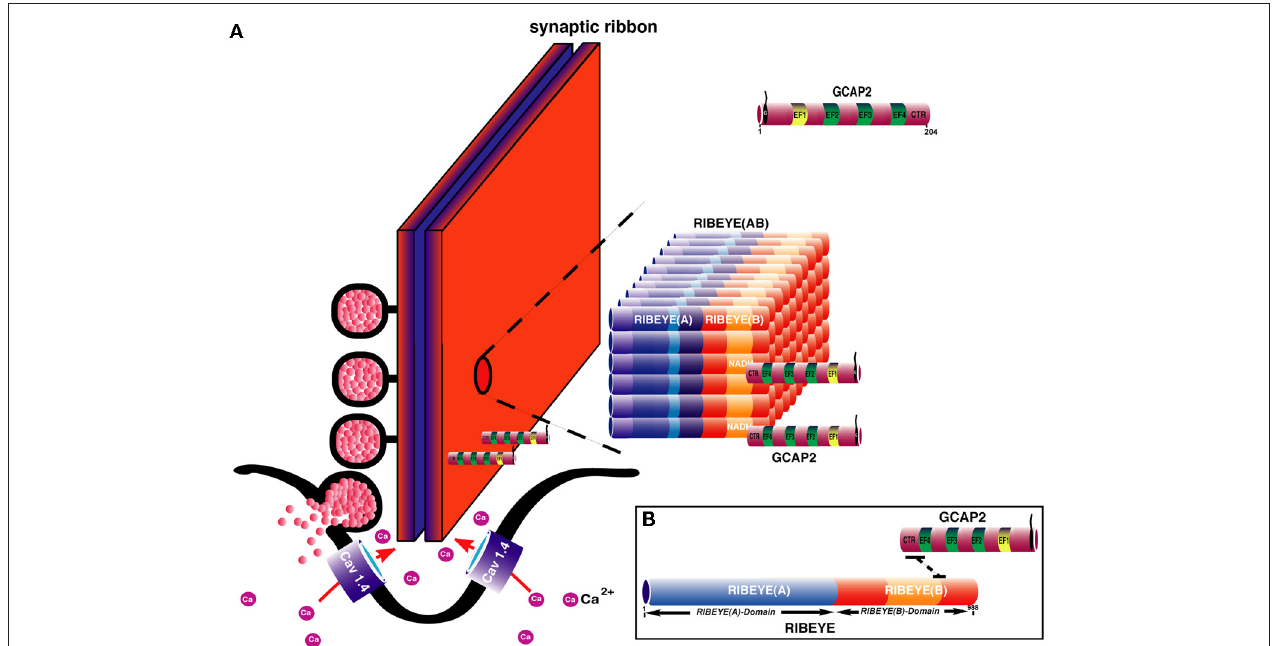
FIGURE 5 | (A) Hypothetical model for the assembly of the synaptic ribbon: the scaffold of the synaptic ribbon is built by RIBEYE proteins, the major, and unique component of synaptic ribbons via multiple RIBEYE-RIBEYE interactions [Magupalli et al. (2008); Schmitz (2009)]. In this model, the A-domain is located in the center of the ribbon to build the core of the synaptic ribbon. The B-domain faces the cytoplasmic side of the synaptic ribbon where it interacts with various proteins, e.g., Munc119 (see also Figure 2 ) and with the GCAP2. Interaction with GCAP2 could regulate assembly and disassembly of synaptic ribbons which is known to be Ca 2 + -dependent [Vollrath and Spiwoks-Becker (1996); Schmitz (2009)].